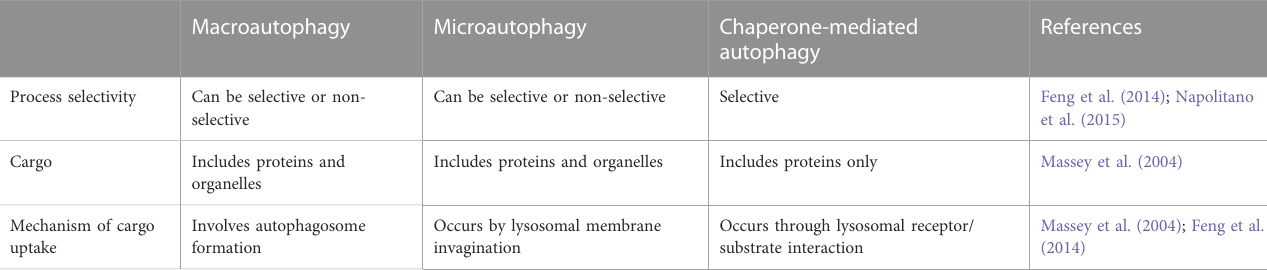
TABLE 2 The main characteristics of different types of